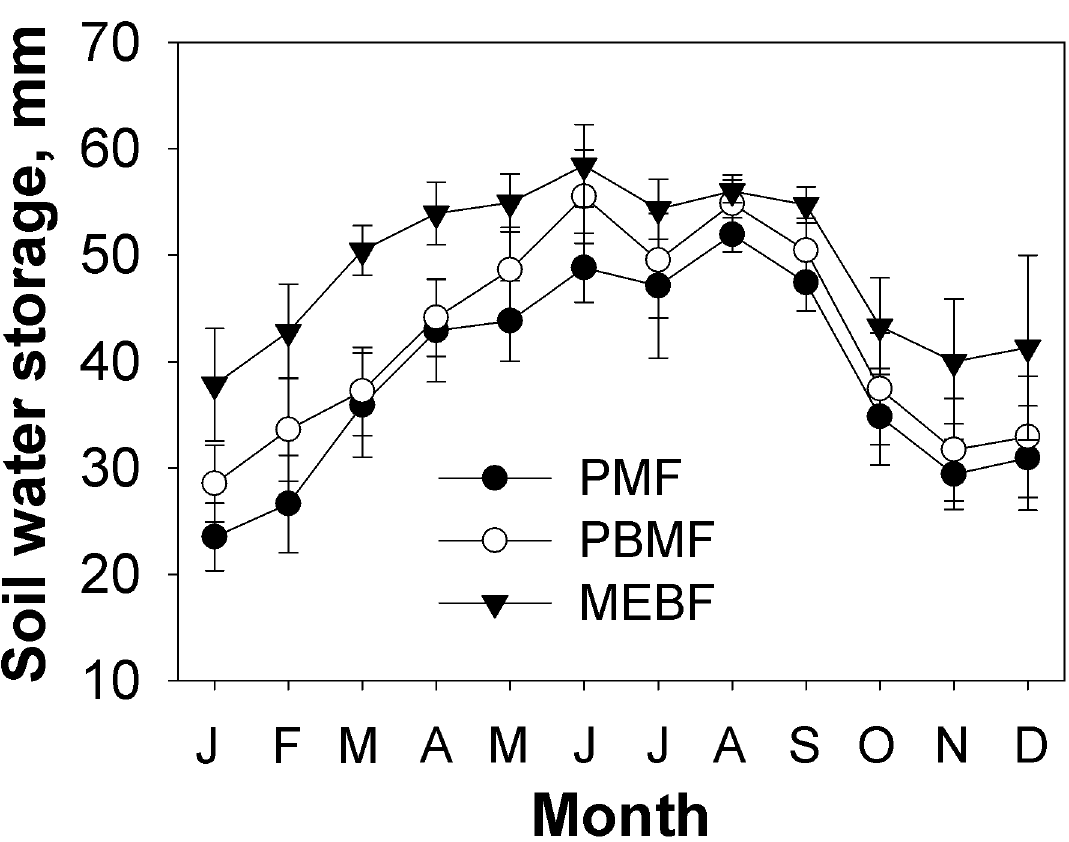
Figure 2. Mean monthly dynamics of soil water storage in the three forest types from 1999 to 2009 ( Pinus massoniana forest (PMF), pine and broadleaf mixed forest (PBMF), and monsoon evergreen broadleaf forest (MEBF). doi: